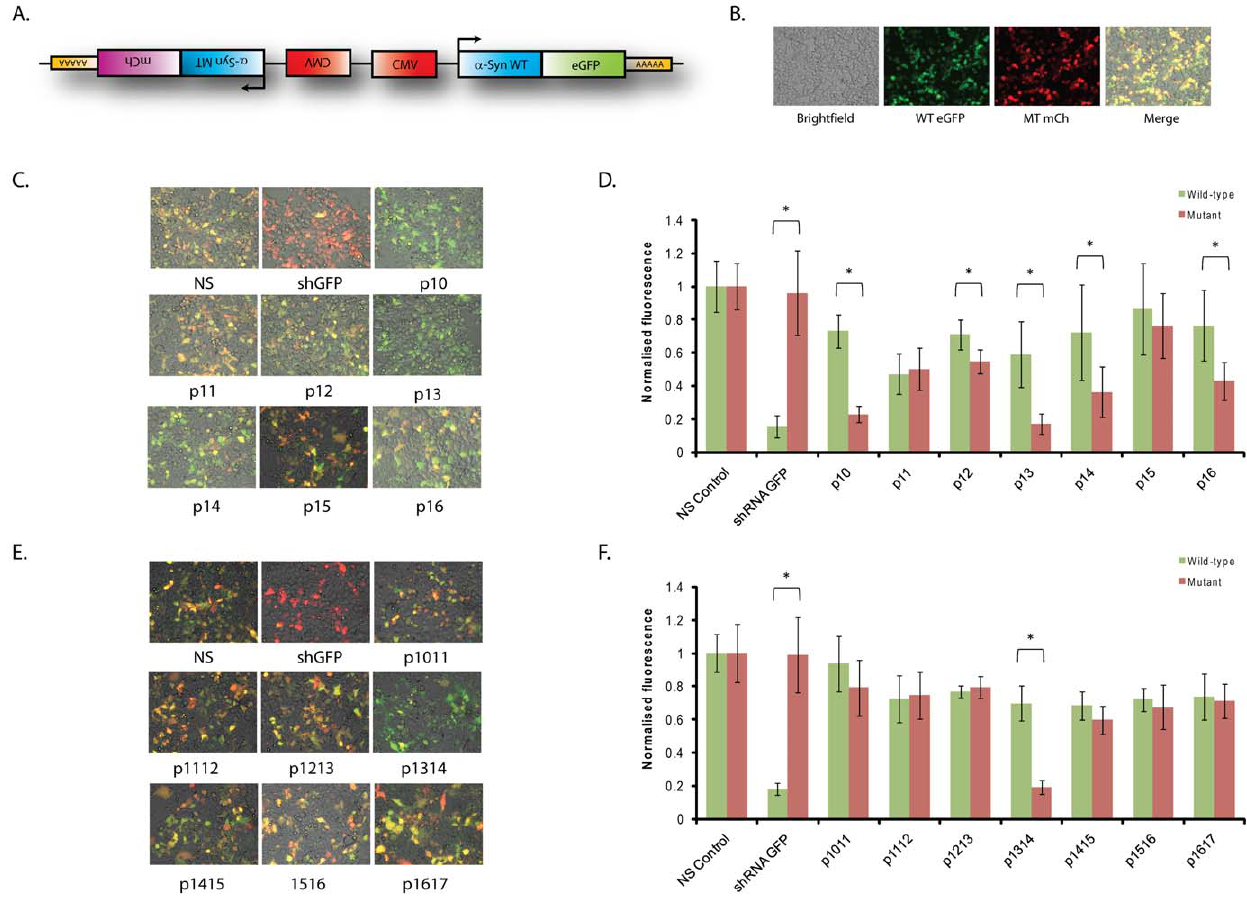
Figure 2. Screening of A30P-targeting shRNAs against the heterozygous eGFP-tagged wild-type and mCherry-tagged A30P mutant a -synuclein expression plasmid. A) eGFP-tagged wild-type a -synuclein and mCherry tagged A30P mutant a -synuclein were expressed in anti- parallel directions to one another in the Het A30P plasmid. B) Expression of the Het A30P plasmid resulted in robust eGFP fluorescence and robust mCherry fluorescence at 48 hrs post-transfection in HEK-293 cells. C + E) Representative merged fluorescent images of HEK-293 cells co-transfected with the Het-A30P plasmid and indicated single (C) or double (E) mismatch shRNA construct at 48 hrs post-transfection. D + F) Quantification of wild- type a -synuclein eGFP (green bars) or A30P mutant a -synuclein mCherry (red bars) fluorescence at 48 hrs post-transfection following co-transfection of single (D) or double (F) mismatch shRNAs targeting the A30P a -synuclein mutant with the Het-A30P plasmid. Values represent mean ratios of normalized fluorescence + / 2 S.D. from n=6. Values are normalized to respective fluorescence in cells transfected with non-specific shRNA. *=P , 0.05 relative to respective normalising control.